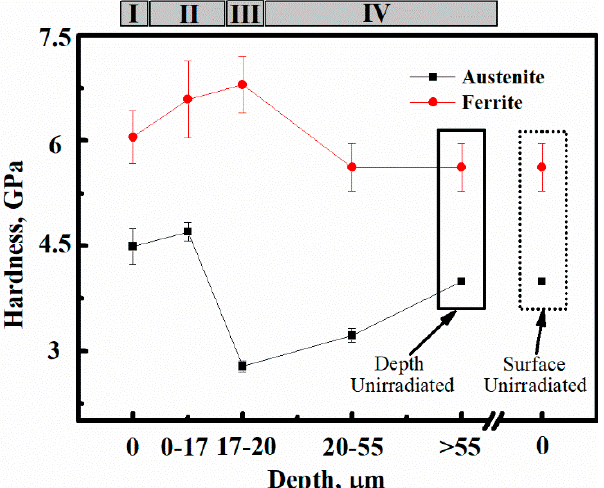
Figure 5. The hardness of the two phases in different regions: from the irradiated surface region I, uniform damage region II, maximum damage region III, to the unirradiated region IV along the depth direction, and the unirradiated surface and depth datapoints.